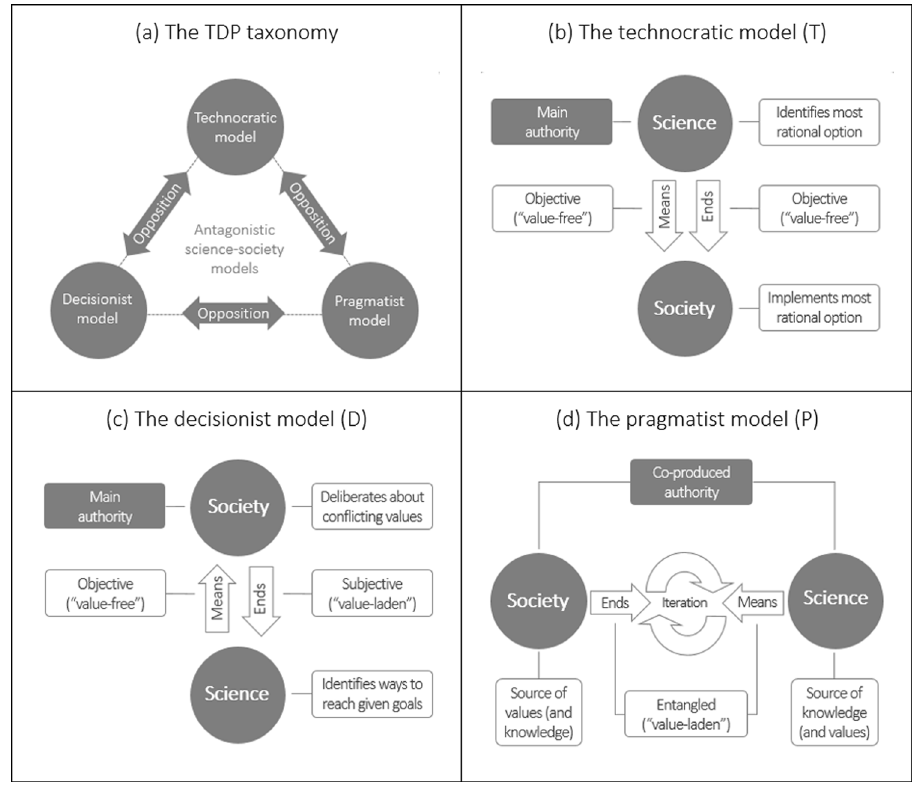
Fig. 1 The TDP taxonomy. The included SSIMs are typically conceived as antagonistic ( a ). The technocratic model assigns a strong decision authority to science ( b ). The decisionist model assigns the main decision authority to society ( c ). In the pragmatist model, the decision authority is co-produced in an iterative exchange between science and